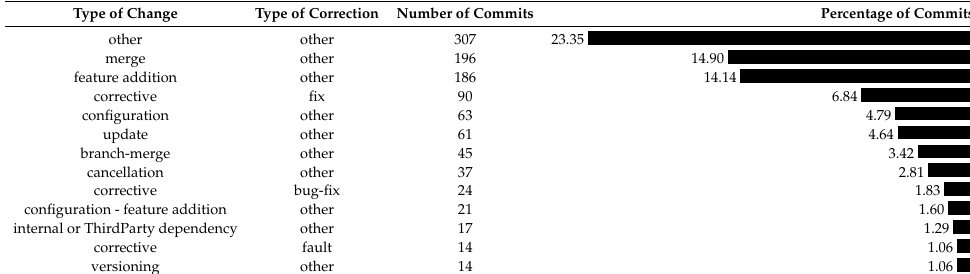
Table 6. AliDPG—examples of distribution of